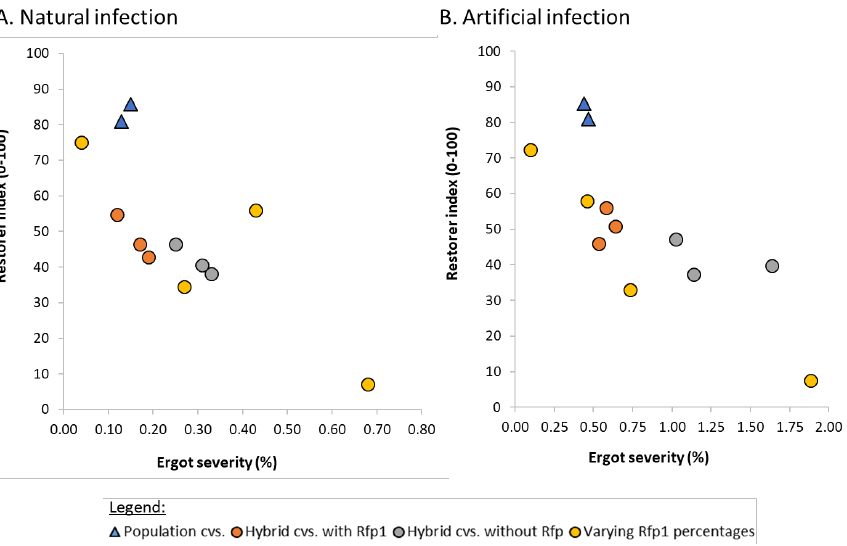
Figure 6. Ergot severity and restorer index of different types of cultivars (cvs., varying Rfp1 per- centages are 100%, 50%, 25%, 0%, respectively) with ( A ) and ( B ), both across eight locations (Data source: ( A ) unpublished, ( B ) [71]).